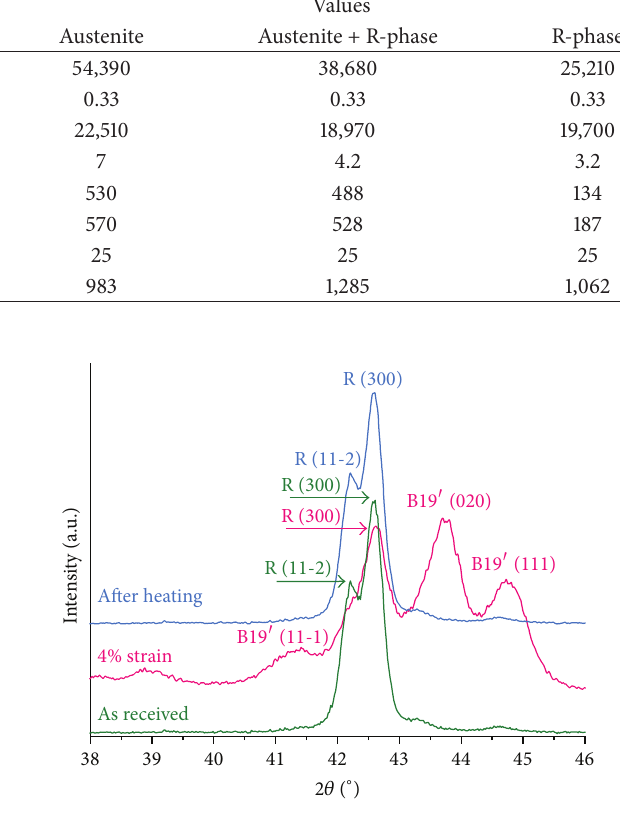
Figure 5: Stress-strain curves for three different NiTi wires used in this study.